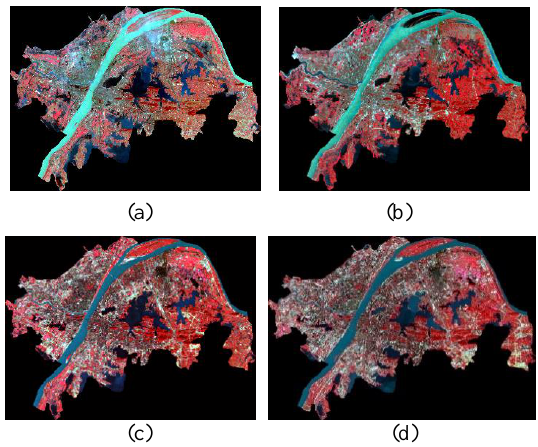
Figure 2. Multi-temporal Landsat images for the study area: (a) 1991, (b) 2002, (c) 2011, and (d)